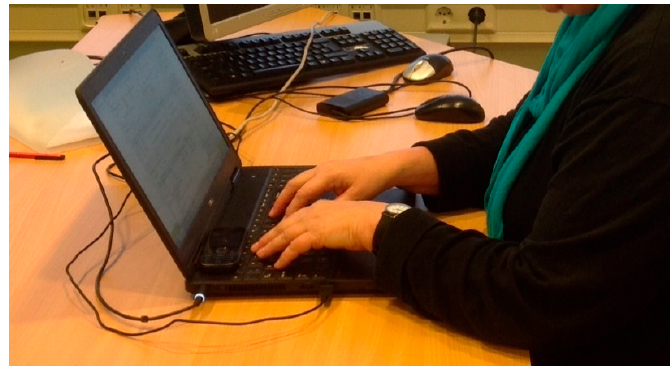
Figure 1. The 59-year-old female civil servant showing how she worked with her laptop when symptoms significantly affected her activities of daily living and work after she had returned to work.